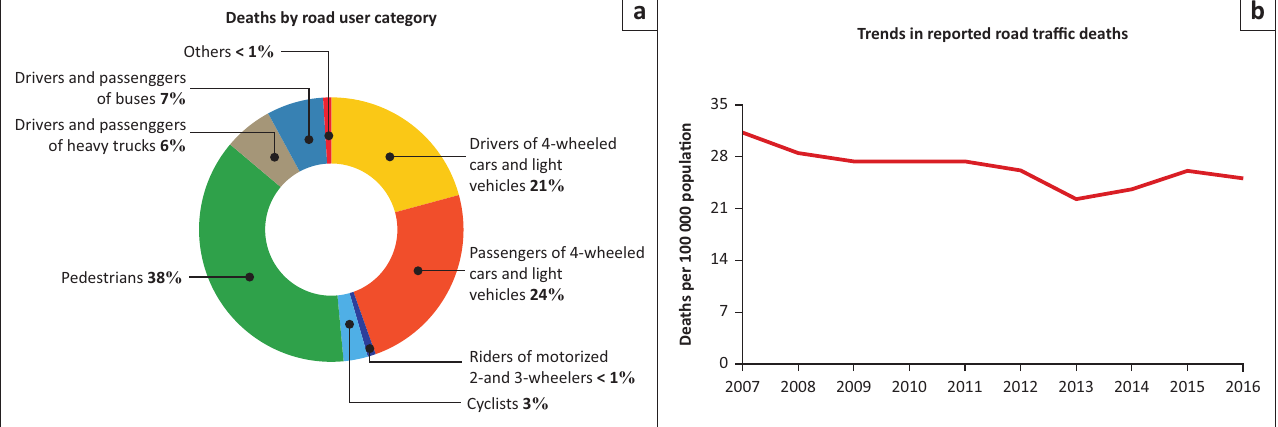
FIGURE 3: Trends in road traffic deaths in the Republic of South Africa